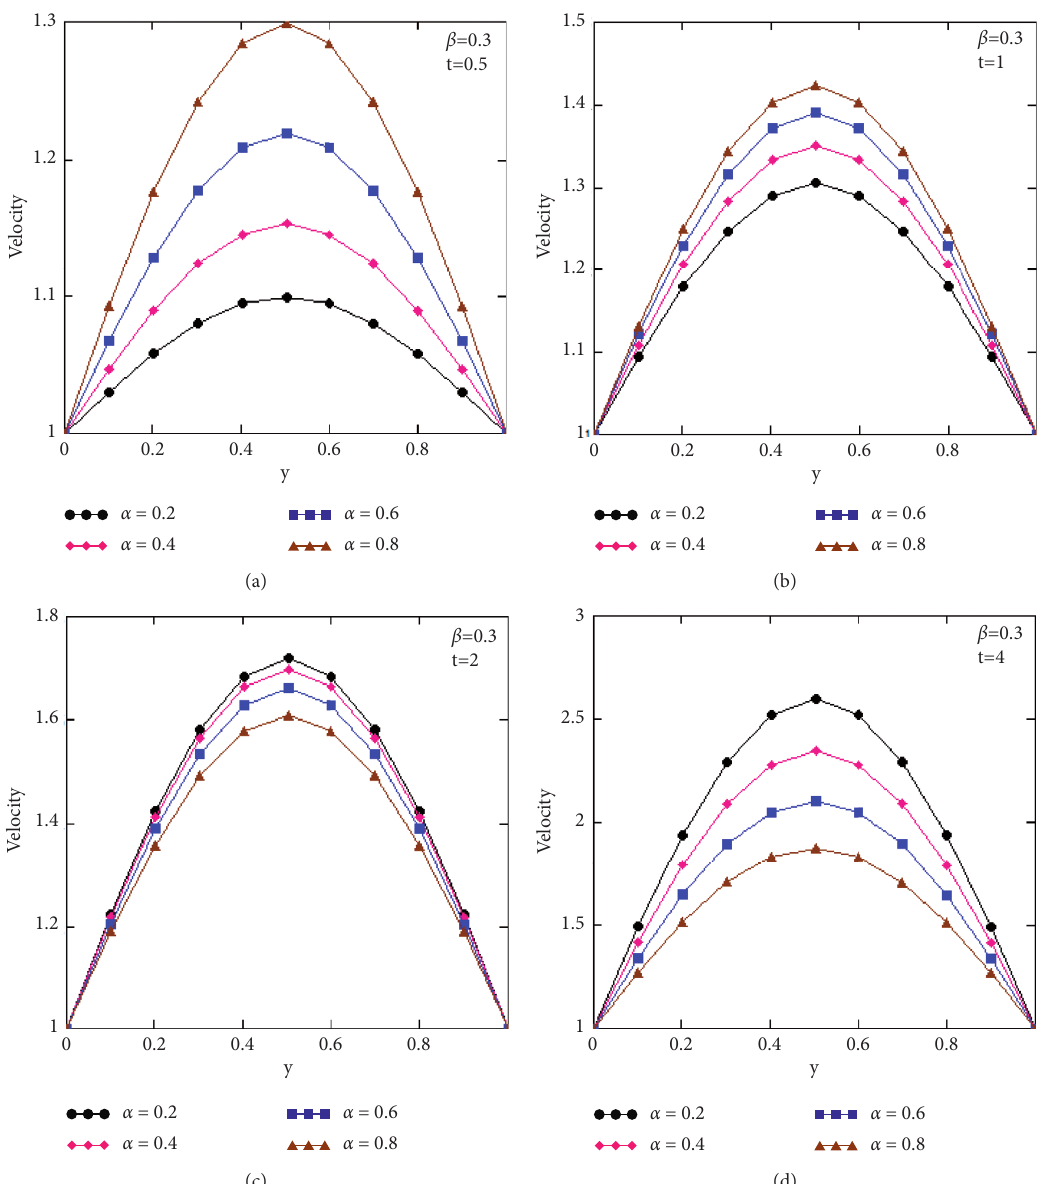
Figure 7: Profiles of dimensionless velocity versus y for variation of α at altered values of time t , Gr � 5 , λ � 2 , λ ( t ) � H ( t ) , f ( t ) � e − 5 t , and g and f 1 2